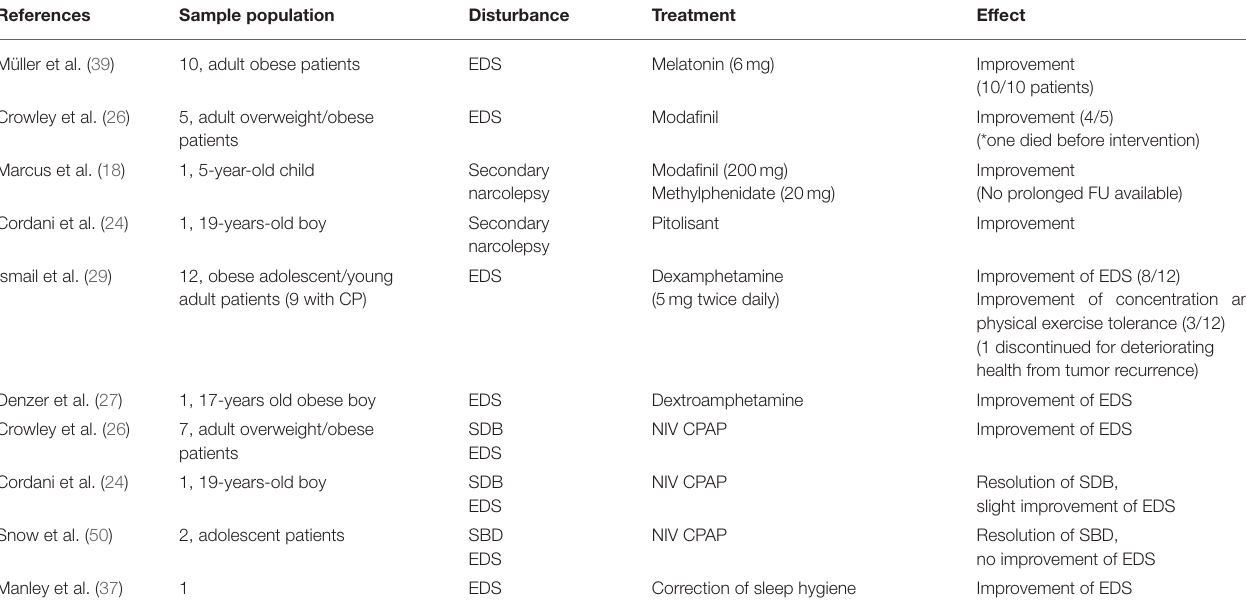
TABLE 3 | Treatments of sleep disorders in patients with